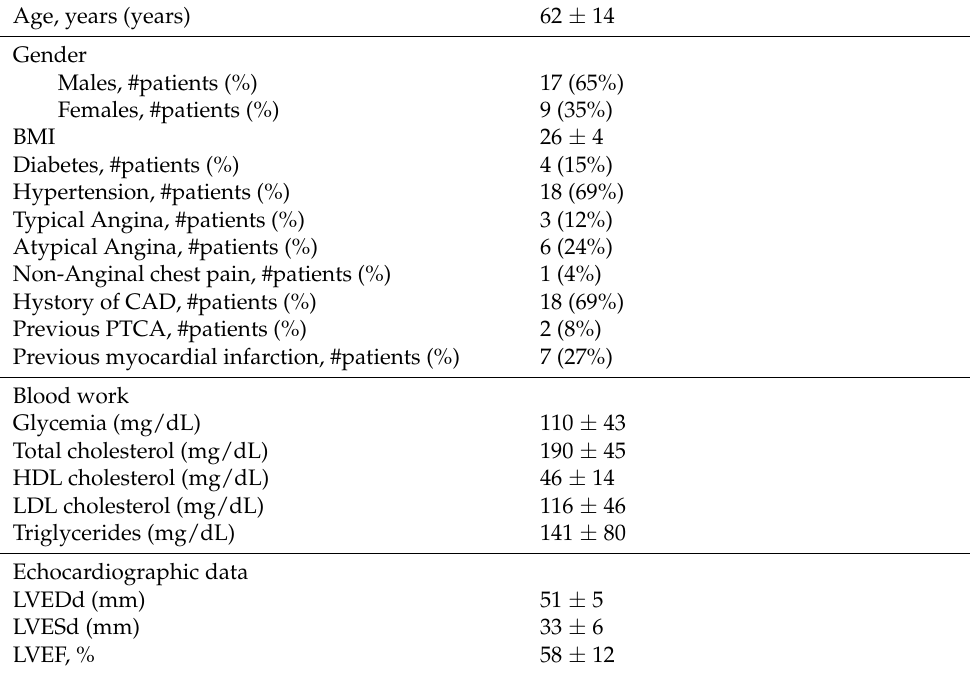
Table 1. Demographic, clinical and echocardiographic data in 26 patients.